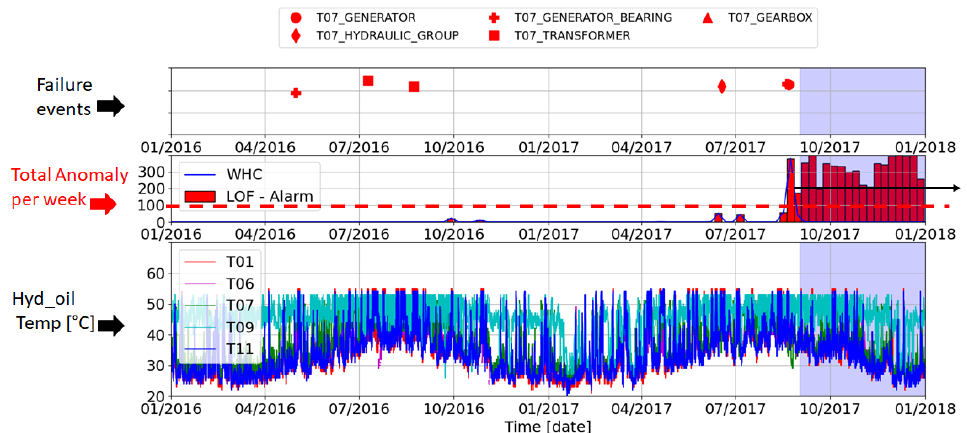
Figure 6. Time series of hydraulic oil temperature of the five turbines and the total anomaly per week detected by the WHC-LOF method (red bar). The red dashed line is the threshold alarm when the cumulative anomaly event is above 100/week. The black arrow indicates the expected failure in the next